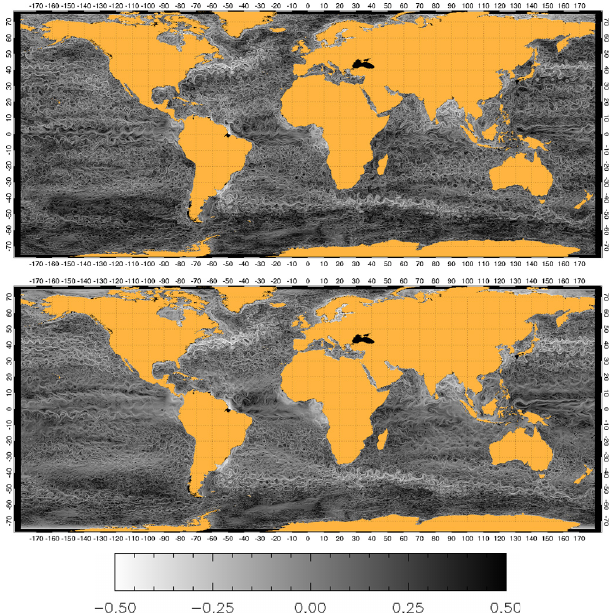
Fig. 6. Top: Singularity exponents associated with SSS. Bottom: Singularity exponents derived from the fused SSS map.